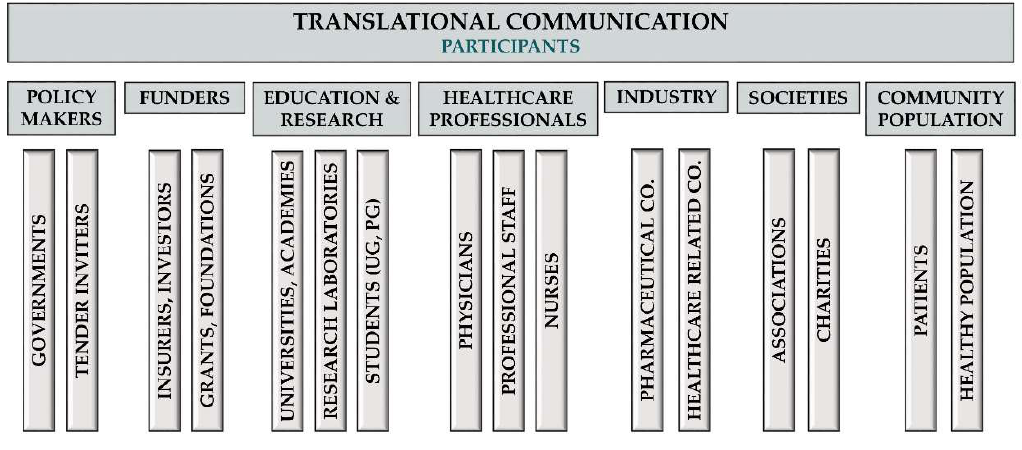
Figure 6. Participants of translational